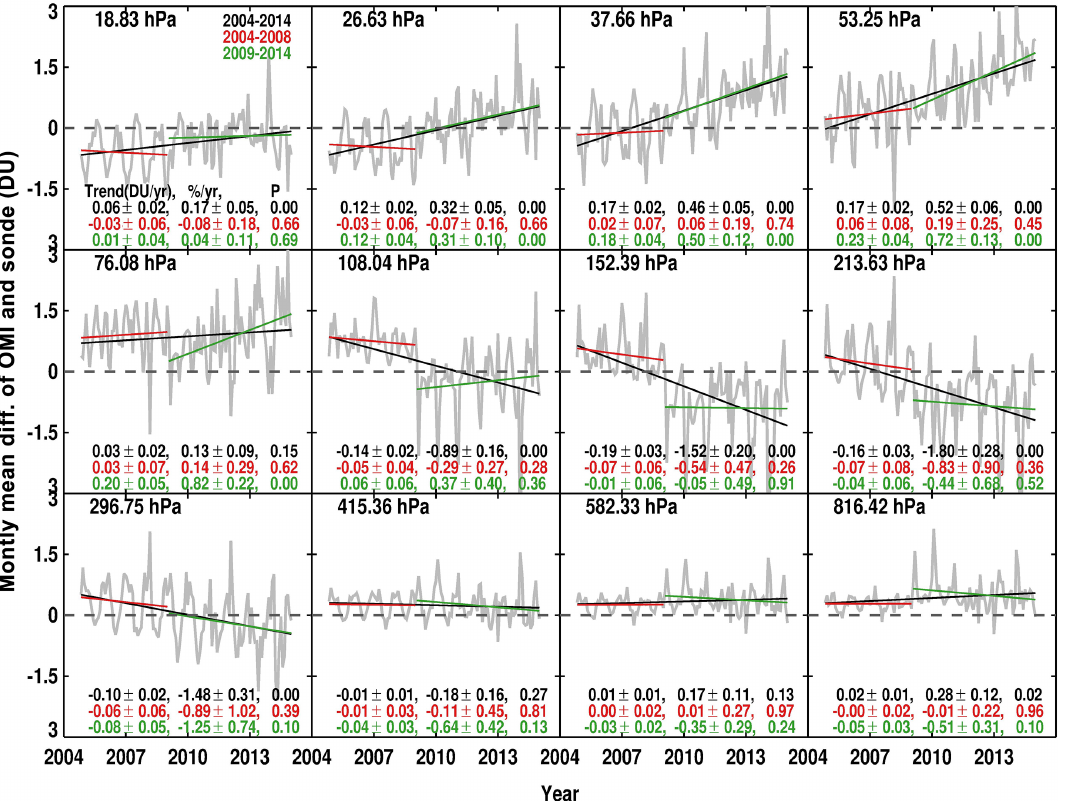
Figure 13. Monthly mean variation of OMI and ozonesonde mean biases in 60 ◦ N–60 ◦ S at each OMI layer. OMI retrieval averaging kernels are applied to ozonesonde data. The black, red, and green lines represent the linear ozone bias trends in 2004–2014, pre-RA (2004–2008), and post-RA (2009–2014), respectively. The average altitude of each layer is marked on the left corner of each grid. The trends in DUyear − 1 or % year and P value for each time period are indicated in the